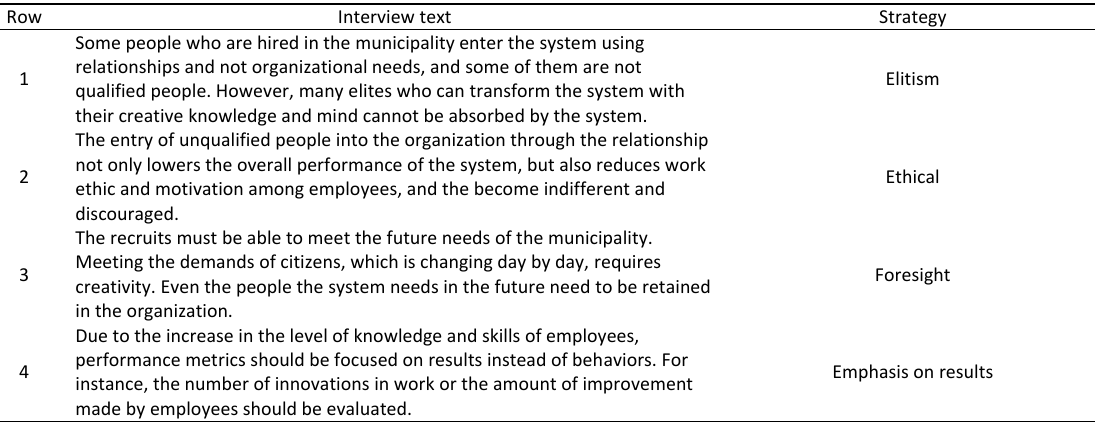
Table 1: Sample text of interviews and extracted codes